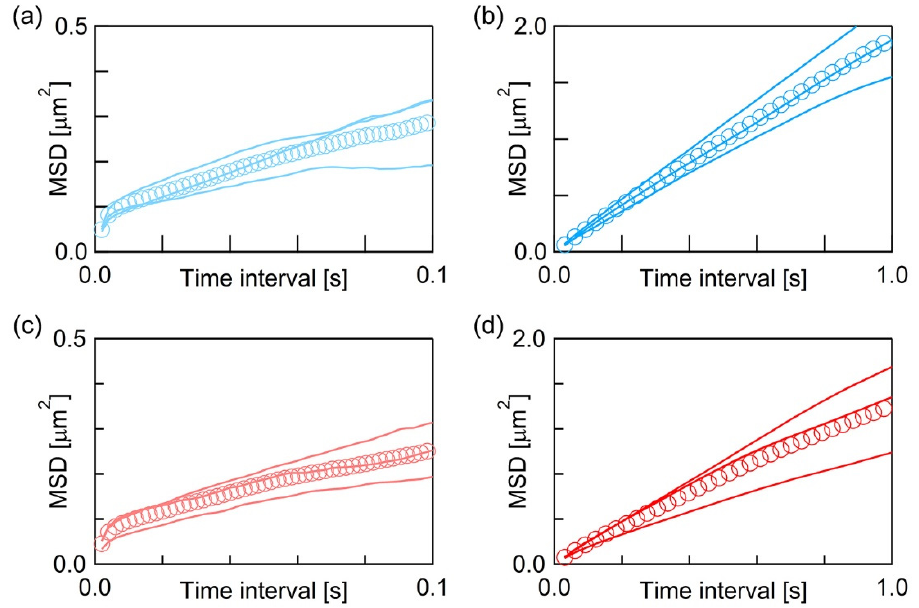
Figure 3. Average MSD- τ plots of ( a , b ) BODIPY-HPC and ( c , d ) DiI-C18 in PI+PC-SLB. The frame rates are 500 fps in ( a ) and ( c ), and 30 fps in ( b ) and ( d ).